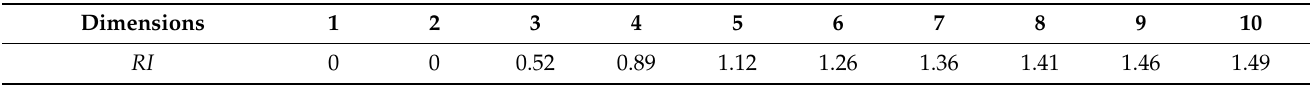
Table 1. Dimensions and corresponding RI values [36].